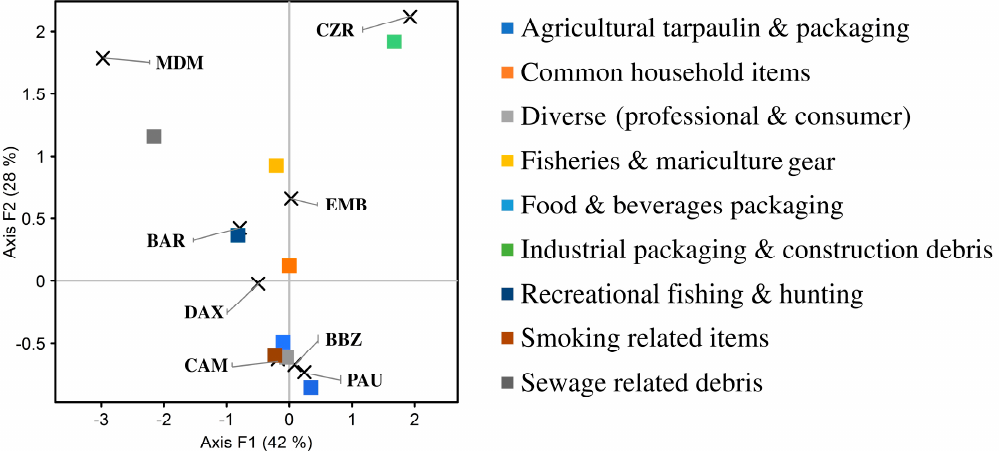
Figure 5. Correspondence analysis showing the spatial distribution of litter according to their uses over the height sampling sites. F1 × F2 is the reduced space used for the correspondence analysis. Inertia of both axis is presented in brackets in the axis legend.